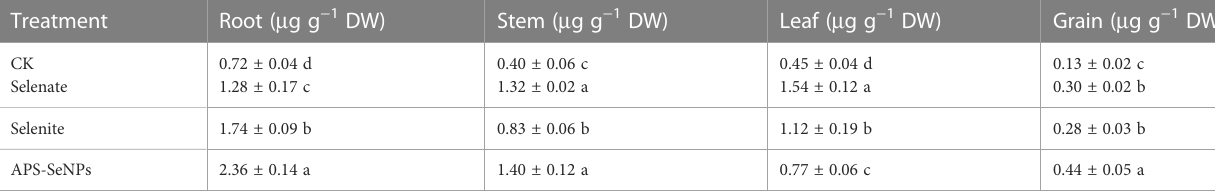
TABLE 2 Selenium (Se) contents of the different parts of rice under different Se treatments.